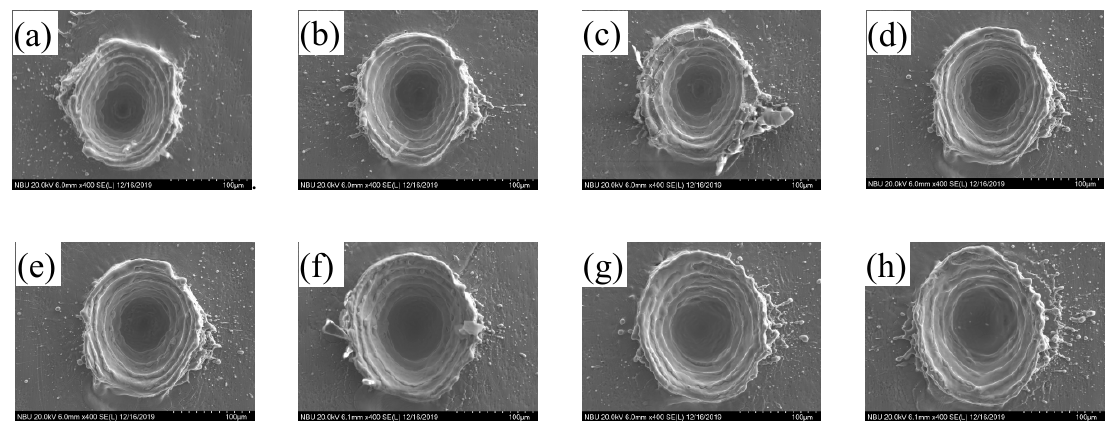
Figure 4. Top-view scanning electron microscope images of ablation craters. (a) 50 °C; (b) 100 °C; (c) 150 °C; (d) 200 °C; (e) 250 °C; (f) 300 °C; (g) 350 °C; (h) 400 °C.